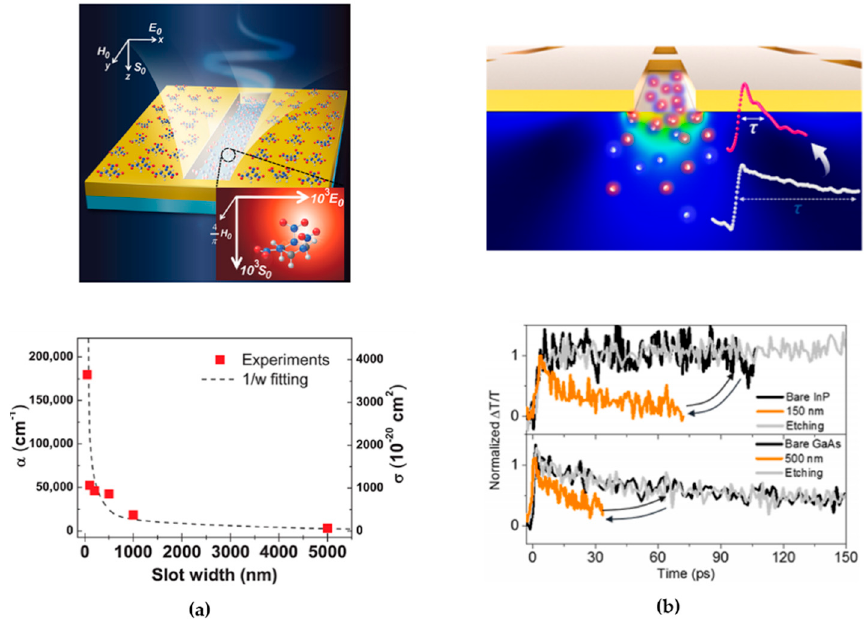
Figure 6. ( a ) Resonant slot antenna achieving an increased absorption cross section when reducing the slot width on the nanoscale. Reprinted with permission from [93] . ( b ) Optical pump-THz probe experiment on slot antennas showing reduced carrier life time due to the surface sensitivity of this method. Reprinted with permission from [96] .